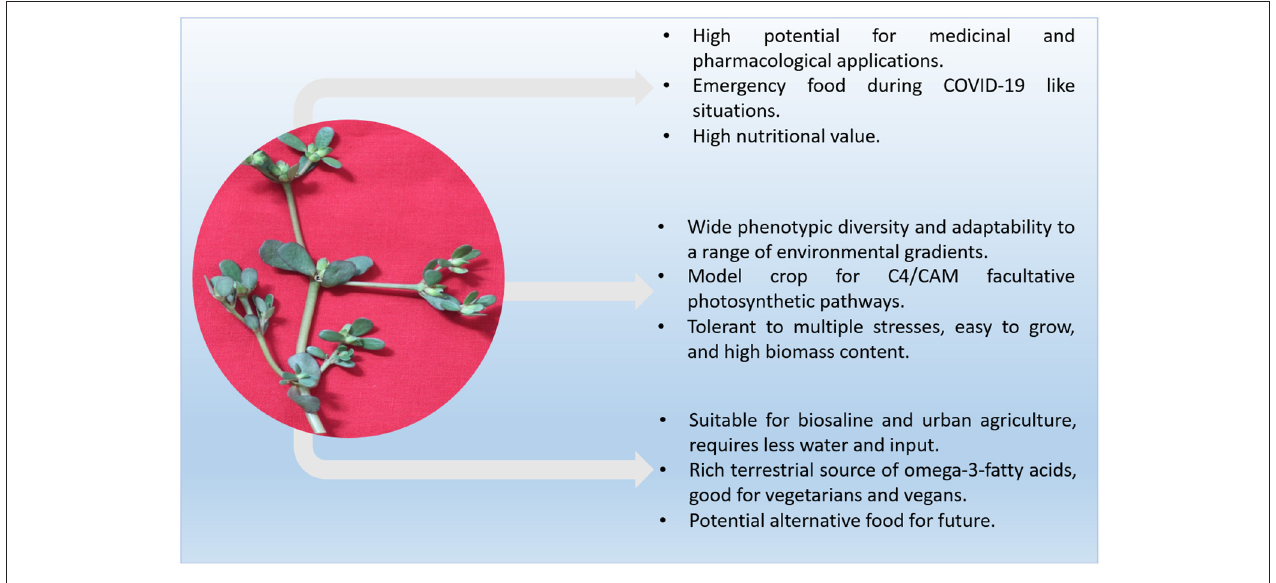
FIGURE 3 | Potential of purslane for sustainable food security and health